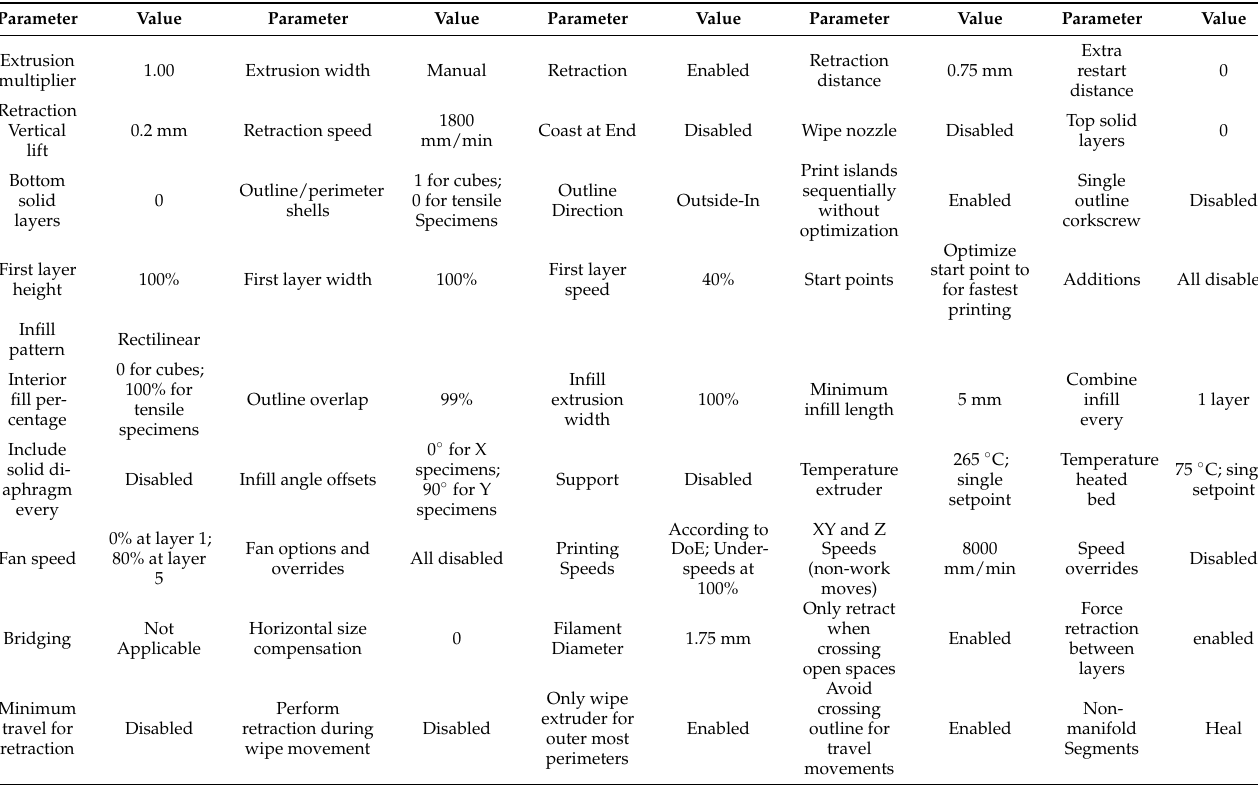
Table A2. Slicer settings in Simplify3d not changed by